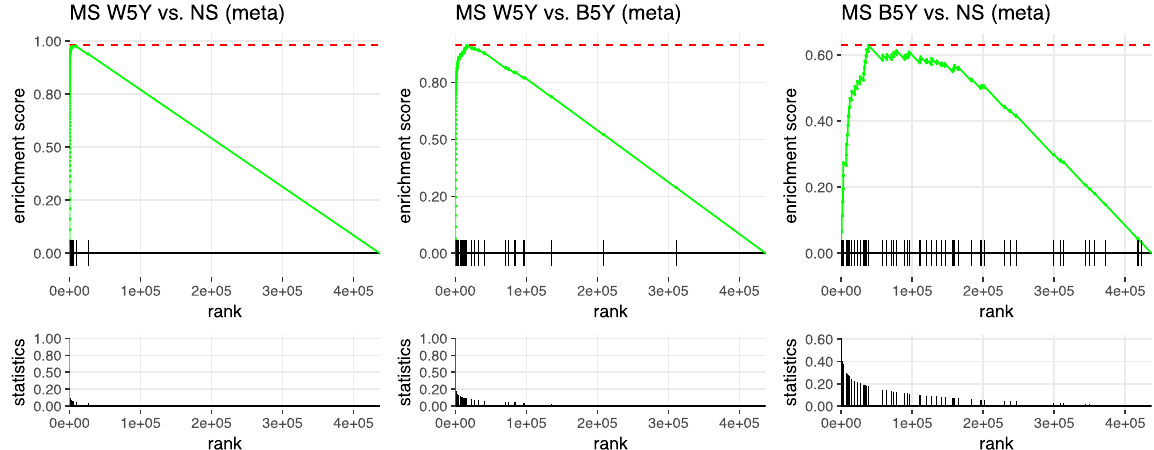
Figure 2. DNA methylation changes are enriched for known sites affected by smoking. A GSEA approach was used to demonstrate that enrichment exists for known smoking-affected CpGs. The green line on the top panels shows the Enrichment Score. Vertical ticks mark the location of the 62 CpGs from Gao et al . 11 within the list of the probes ranked by decreasing significance, and the bottom panels show their corresponding normalized − log 10 P-values (for the comparisons W5Y vs . NS, W5Y vs . B5Y and B5Y vs . NS,